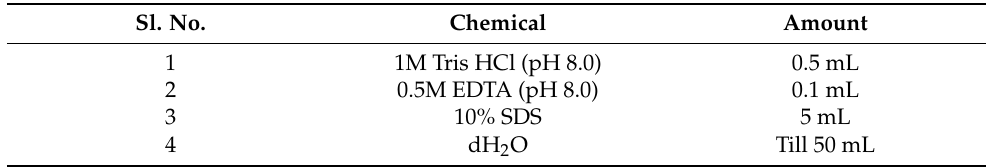
Table 4. Chemicals for LCM lysis buffer.